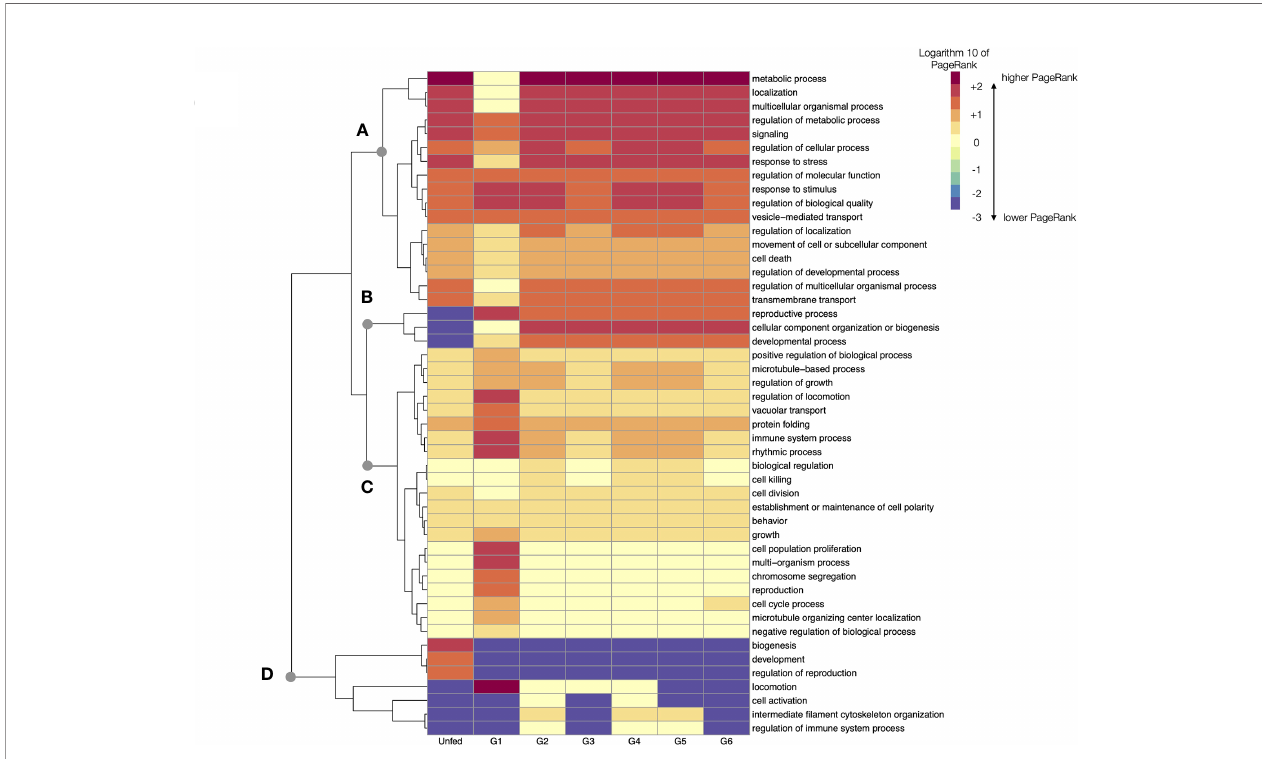
FIGURE 6 | A heatmap displaying the values of the log10 of PageRank of every top-level processes in unfed and feeding R. sanguineus . The heatmap shows the processes grouped according to a dendrogram (left) grouping those processes with similar patterns of variability. Dots labelled (A – D) show breaking points of the dendrogram, intended only as a help for interpretation. The tick group (unfed, G1 to G6) is included at the bottom of the fi gure, following the terminology of the original data by Tirloni et al.